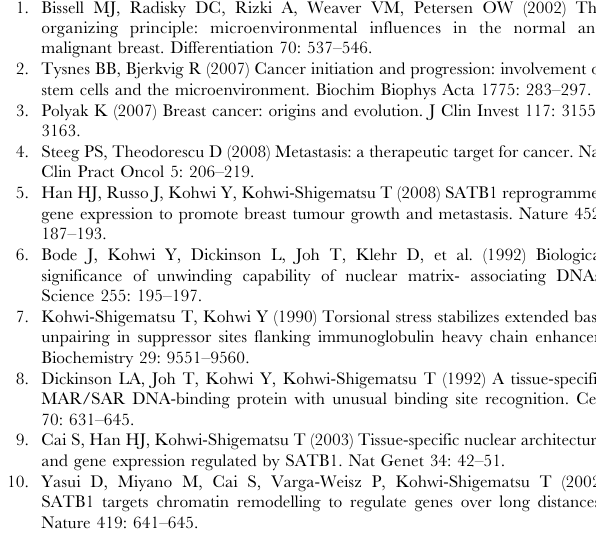
Figure S4 (Top) Schematic diagram of M phase cell cycle checkpoint analysis. Cells were synchronized with 2.5 mM HU for 24 h, followed by removal of HU and continuous incubation in media containing 500 nM paclitaxel. After 0, 18, 22, and 28 h incubation with paclitaxel, cells were analyzed for cell cycle distribution. (Top two rows) Cell cycle profiles of MCF10A-1 treated with HU and HU + paclitaxel. (Bottom two rows) Cell cycle profiles of MCF10A-2 treated with HU and HU + pacltaxel. At 22 h, percentages are shown for each cell cycle gate (Apoptosis, G1, S, and G2/M) to demonstrate a defect in the phase